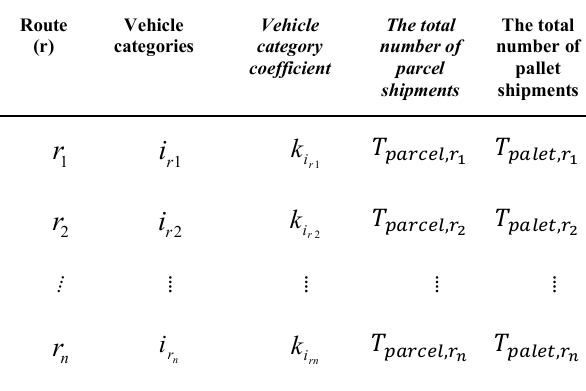
Table 2. Display of routes in the geographical area G